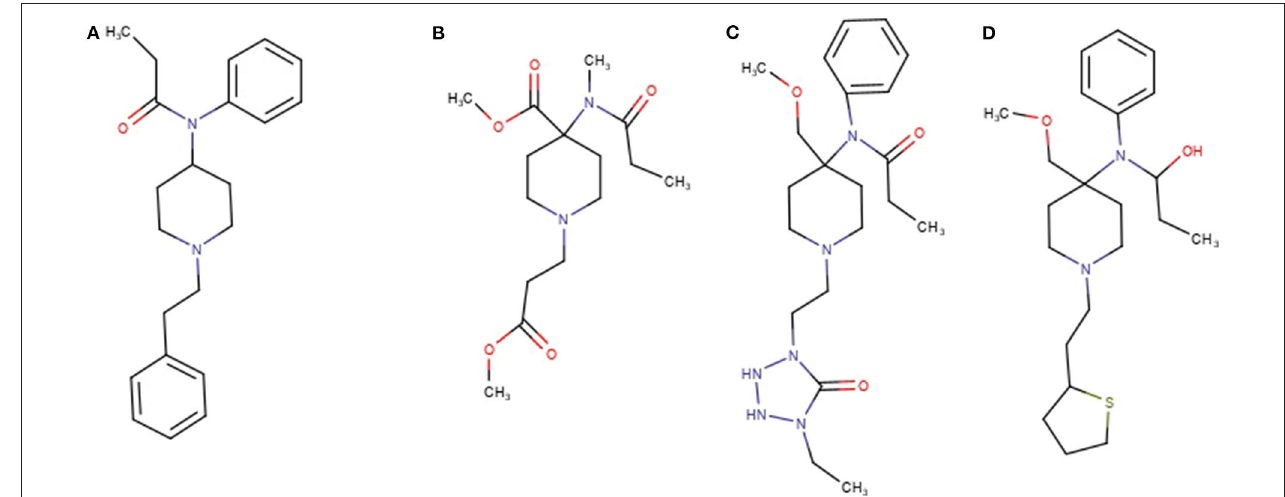
FIGURE 3 | Structures of Fentanyl (A) , remifentanyl (B) , alfentanyl (C) , and sufentanyl (D) .